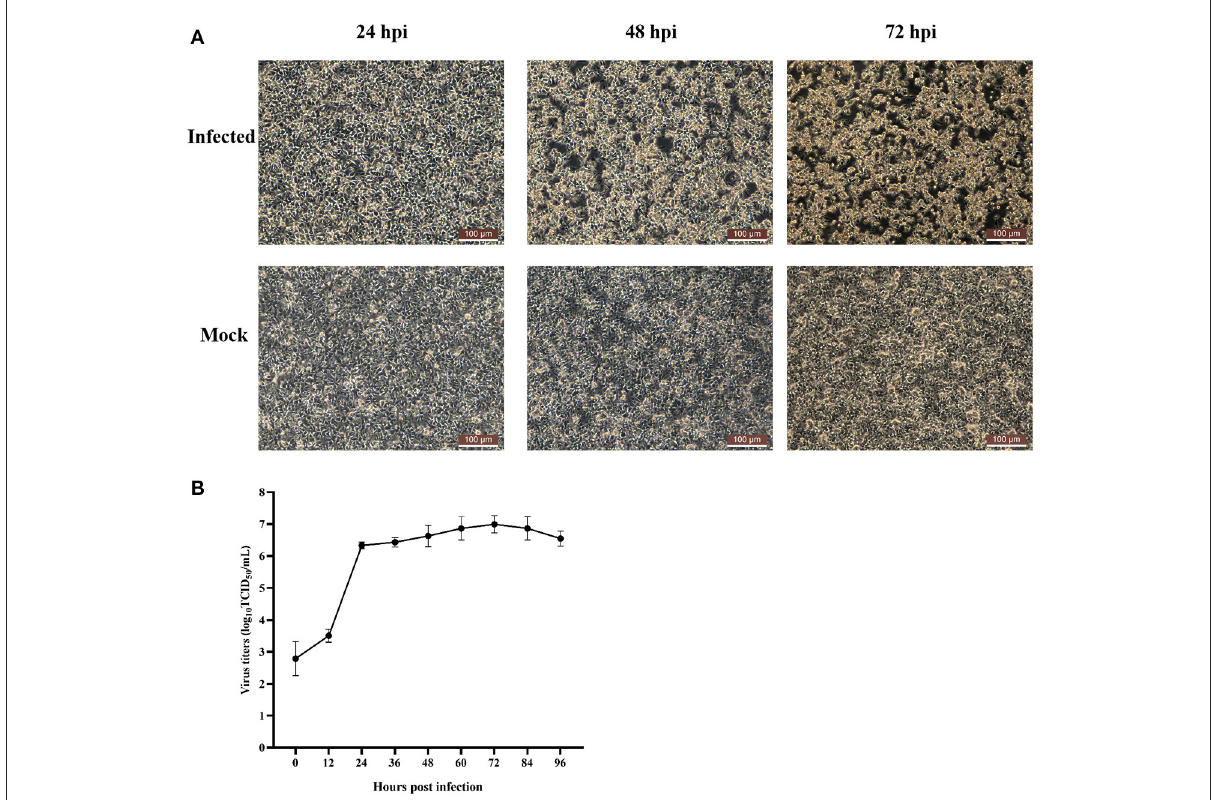
FIGURE1 Cytopathic effect of FAdV-2 strain GX01 infected LMH cells and one-step growth curve. (A) Cytopathic effect of FAdV-2 strain GX01 infected LMH cells and non-infected LMH cells (Mock) at 24, 48, and 72 hpi. Scale bar = 100 µ m. (B) One-step growth curve of FAdV-2 strain GX01 in LMH cells.